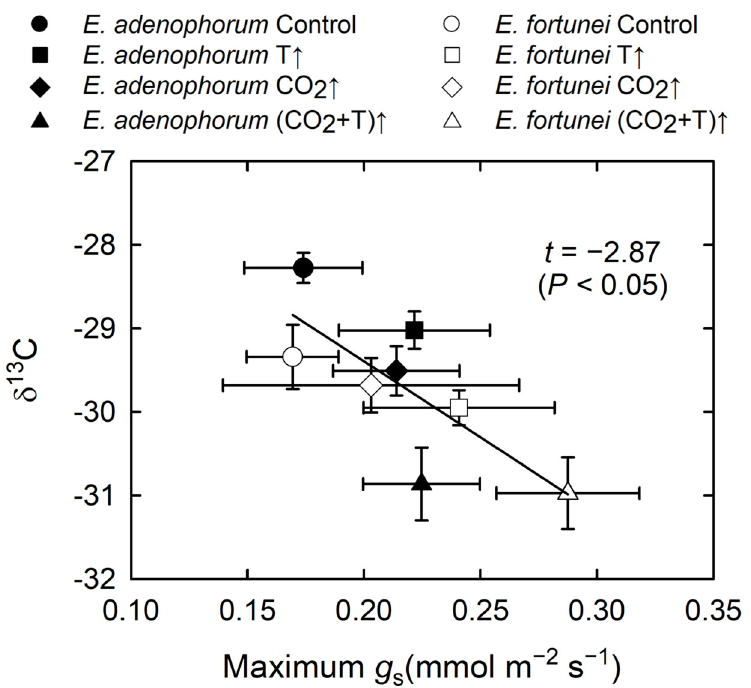
Figure 6. The relationship between leaf water use efficiency (indicated by δ 13 C) and maximum stomatal conductance ( g s ) across species and treatments. Points are means ± SE per species and treatment. A linear mixed model was fitted to the data with species as a random factor.